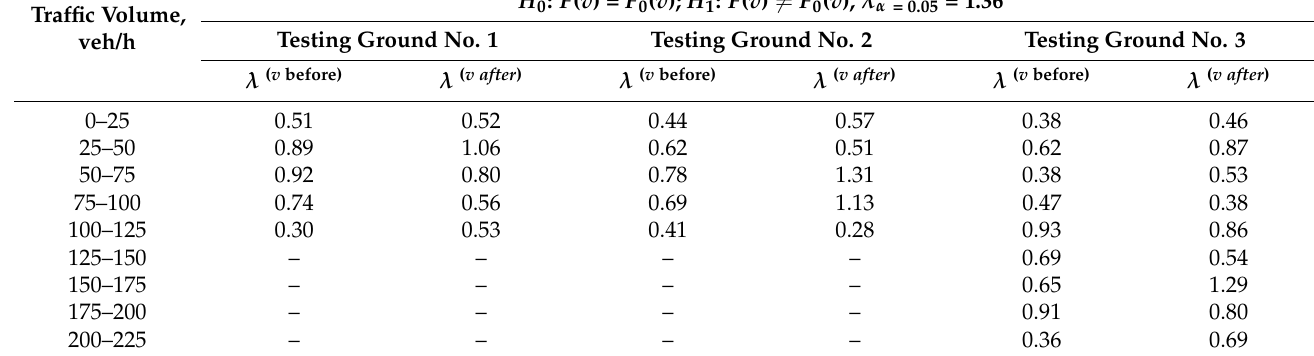
Table A1. Results of standard statistical goodness-of-fit tests.